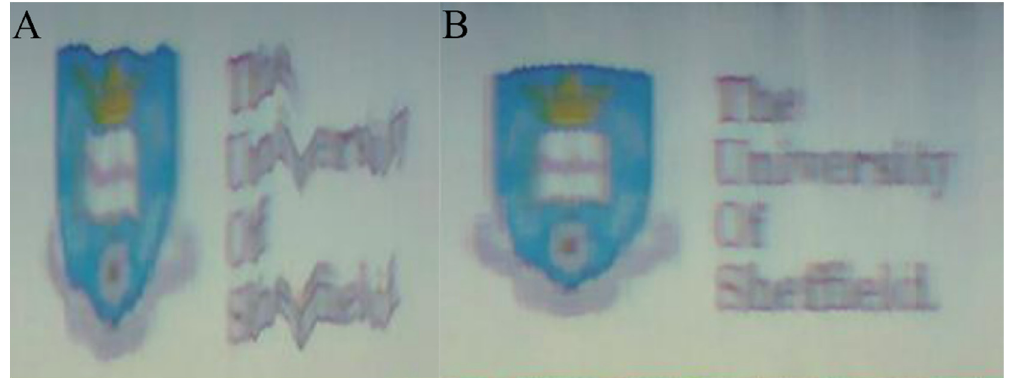
Figure 9. ( A ) An RGB reconstruction from the non-spatially corrected data cube. ( B ) The same image from ( A ) but spatially corrected.